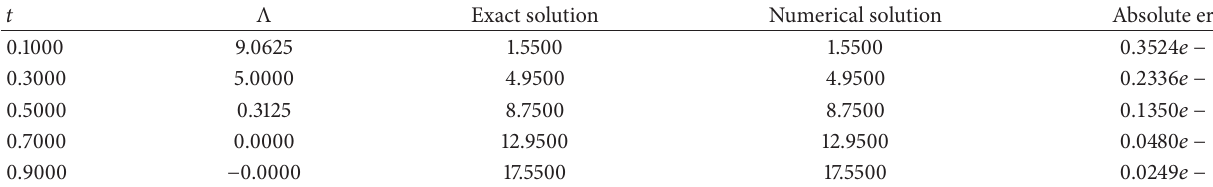
Table 2: Computational results of Example 1 for 𝑅 = 1 and 𝑛 = 4 .